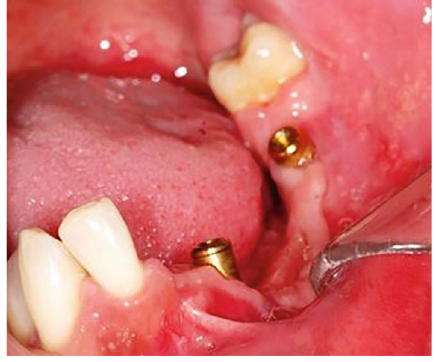
Figure 10: Clinical situation with locators (2020).